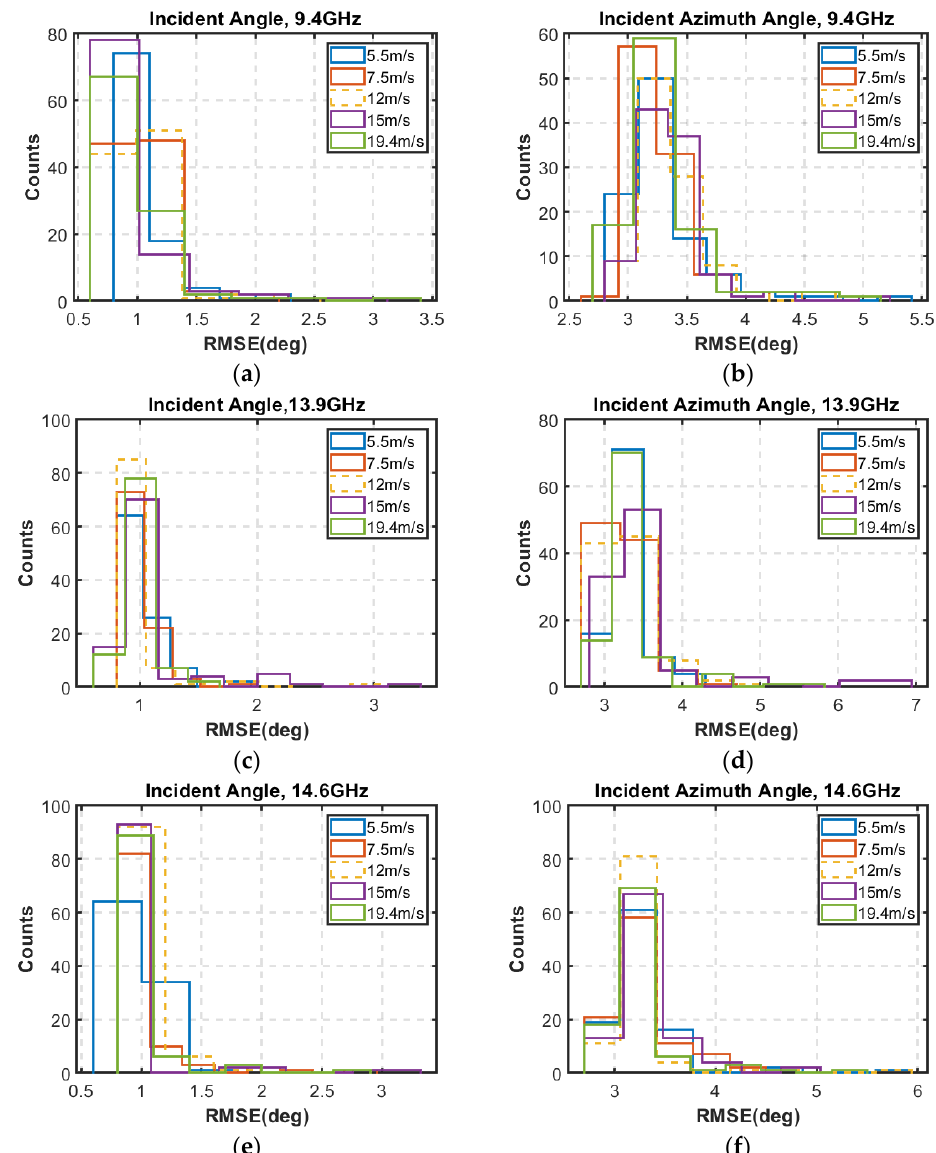
Figure 7. The distribution of RMSE between the truth and predicted incident source for datasets at 13.9 GHz and 14.6 GHz in 100 realizations: ( a ) 9.4 GHz, incident angle; ( b ) 9.4 GHz, incident azimuth angle( c ) 13.9 GHz, incident angle; ( d ) 13.9 GHz, incident azimuth angle; ( e ) 14.6 GHz, incident angle; ( f ) 14.6 GHz, incident azimuth angle.